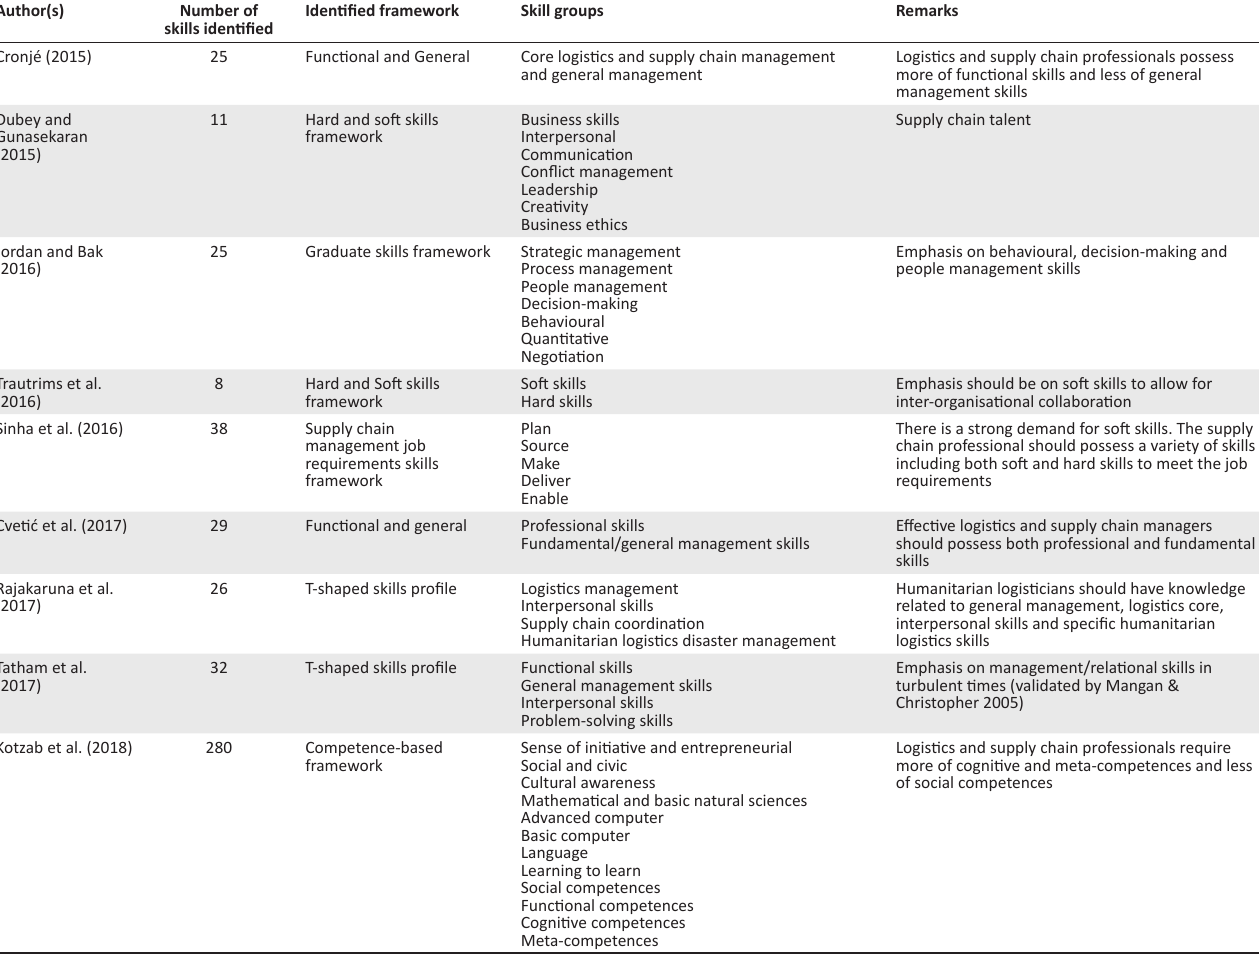
TABLE 9 (Continues...): Supply chain skills frameworks.